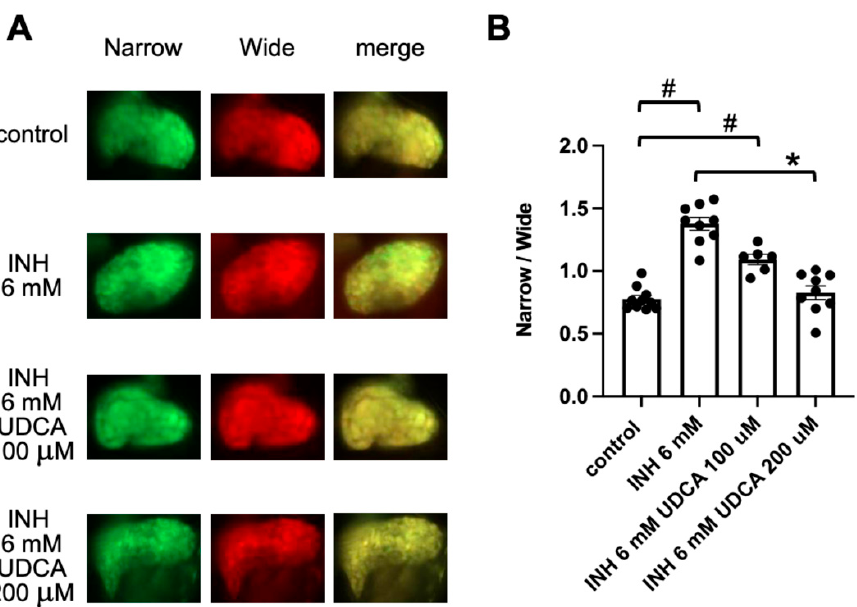
Figure 3. Assessment of hepatic apoptosis in Tg (pck1:Casper3GR) treated with INH with and without UDCA. ( A ) Representative in vivo fluorescence images of Tg (pck1:Casper3GR) treated with INH with and without UDCA from 4 to 5 dpf. Images acquired using narrow and wide filters and merged images are shown. ( B ) Hepatic apoptosis was assessed as the ratio of narrow and wide areas of fluorescence above the threshold in the liver of zebrafish at 5 dpf treated with INH with and without UDCA. Circles represent individual zebrafish, and bars represent the group means with standard error of the means. n = 10, 9, 6, and 9 for control, INH 6 mM, INH 6 mM UDCA 100 μ M, and INH 6 mM UDCA 200 μ M, respectively. # p < 0.05 vs. control, * p < 0.05 vs. INH 6 mM.